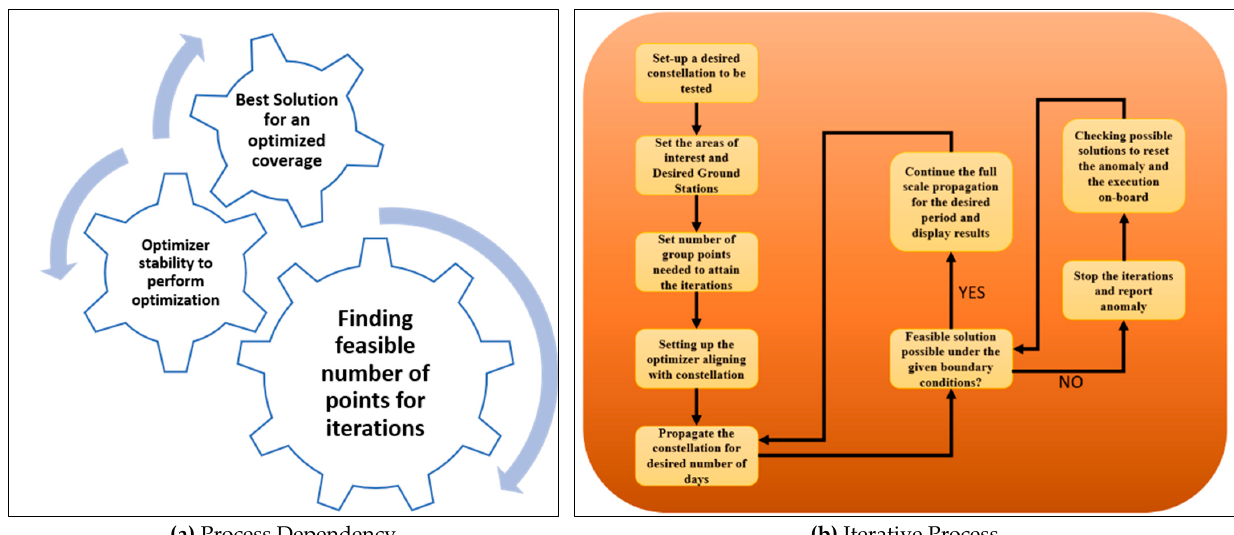
Figure 19. Best solution process and step-wise on-board sequencing.